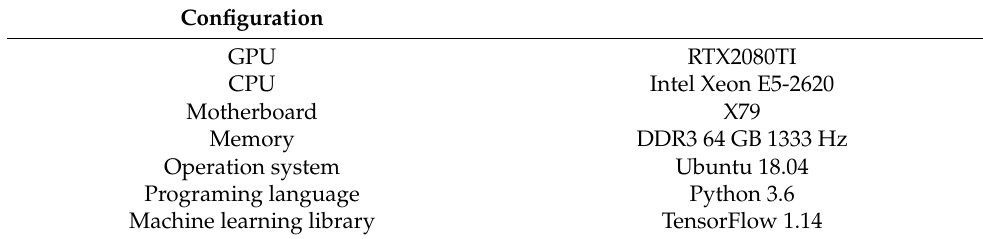
Table 1. Experiment computer